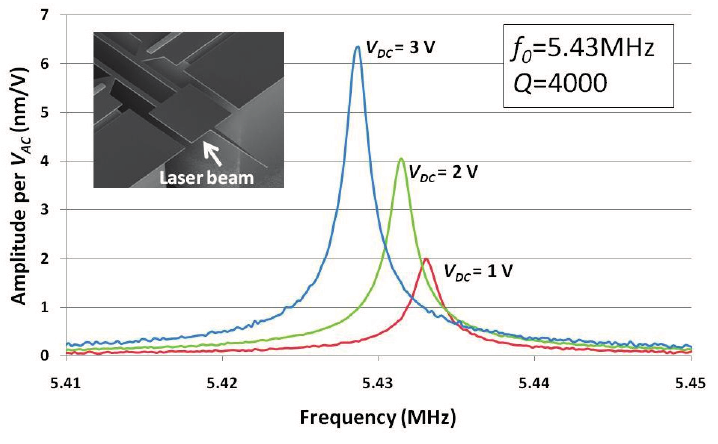
Figure 10. In-plane vibration amplitude (nm/ V AC ) at tip location versus frequency with different bias voltage V DC